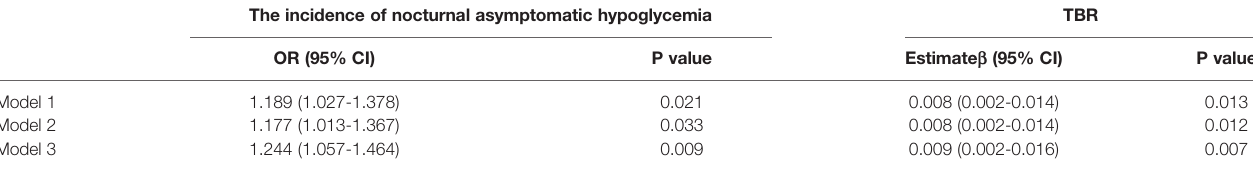
TABLE 2 | Associations between LAGE and the incidence of NAH and TBR. The incidence of nocturnal asymptomatic